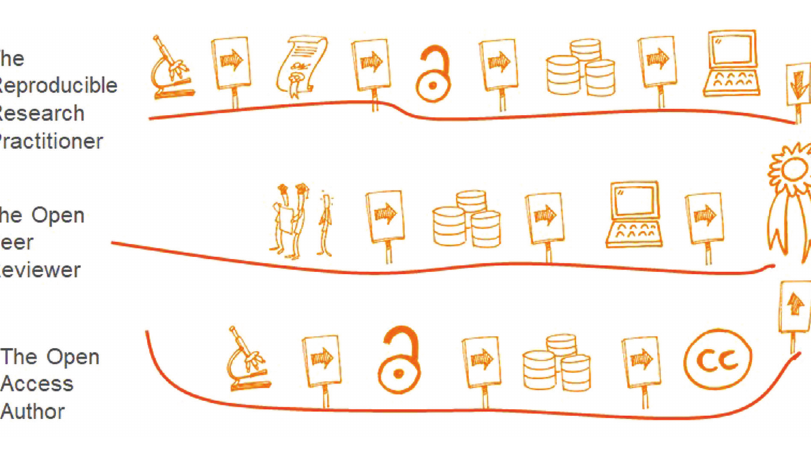
Fig. 8: FOSTER learning